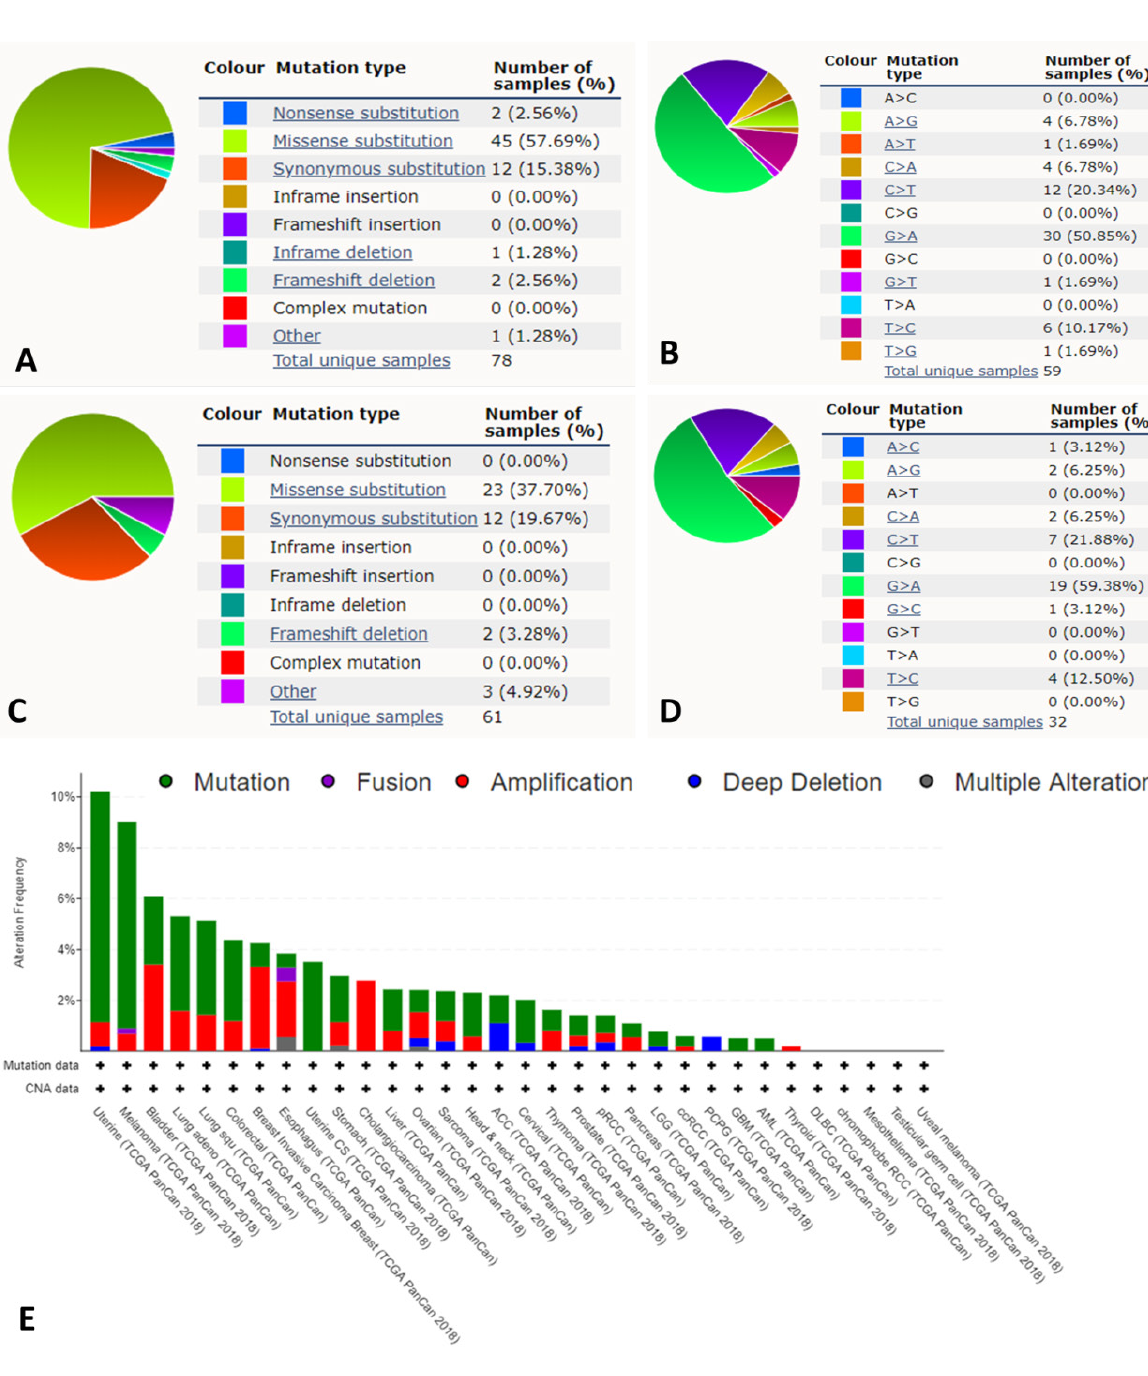
Figure 2: iNOS/NOS2 gene mutation analysis(A: Pie plot of the iNOS/NOS2 mutation frequency of colorectal cancer; B: Pie plot of the iNOS/ NOS2 single nucleotide mutation of colorectal cancer; C: Pie plot of the iNOS/NOS2 mutation frequency of gastric cancer; D: Pie plot of the iNOS/NOS2 single nucleotide mutation of gastric cancer; E:iNOS/NOS2 gene mutation frequency distribution analysis based on TCGA database) The mutation percentage was calculated by the formula of number of cases with mutation/number of cases